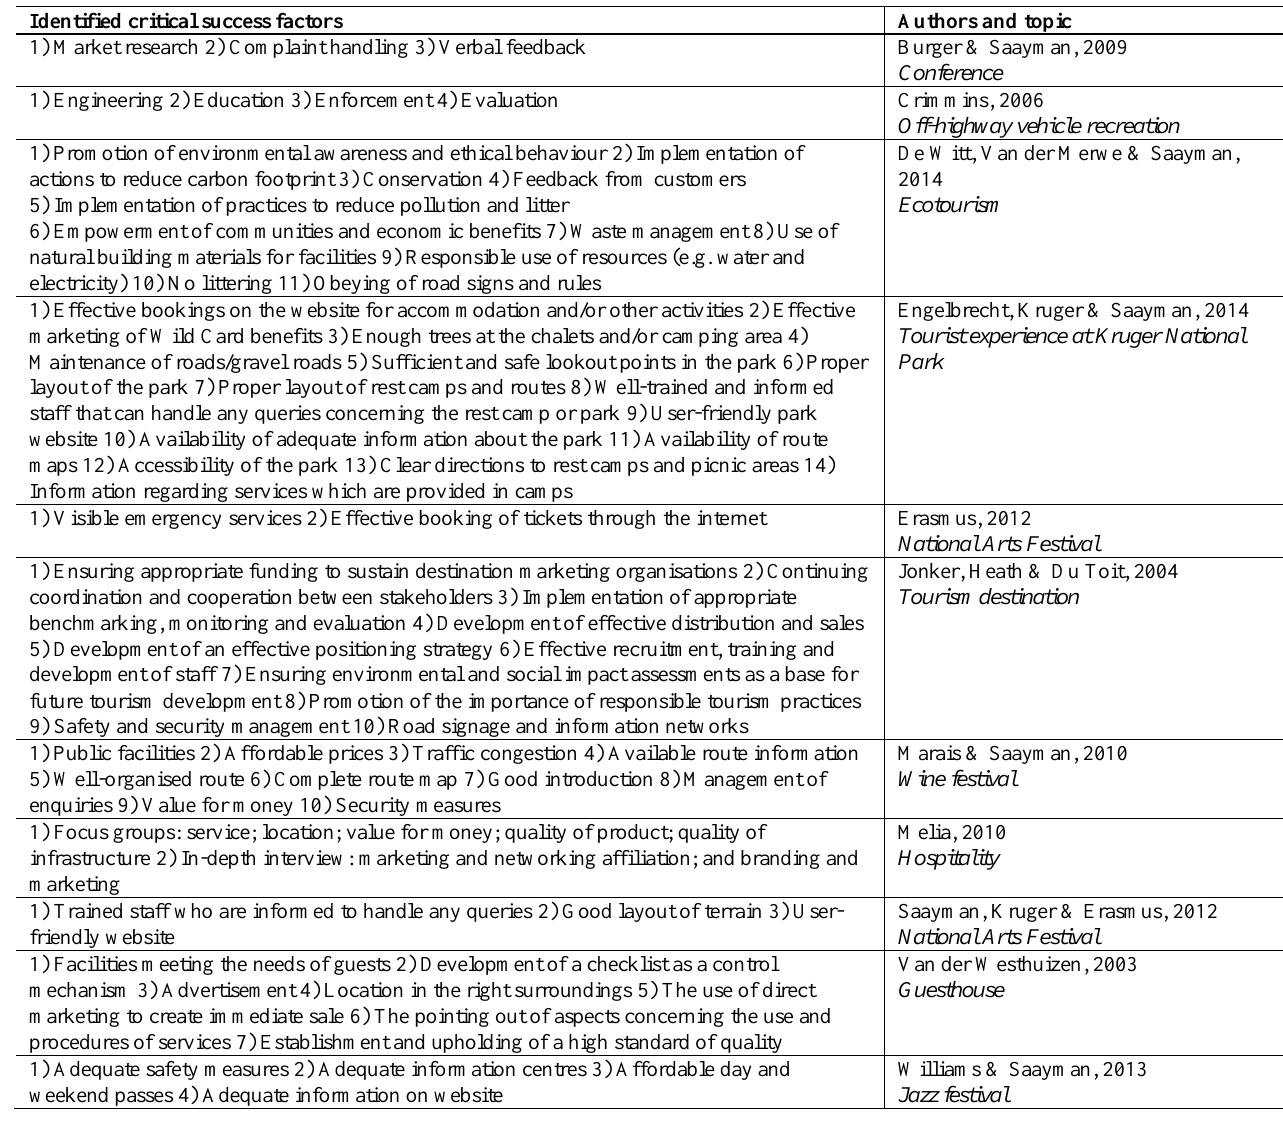
Table 1: Previous research on critical success factors in the tourism field Identified critical success